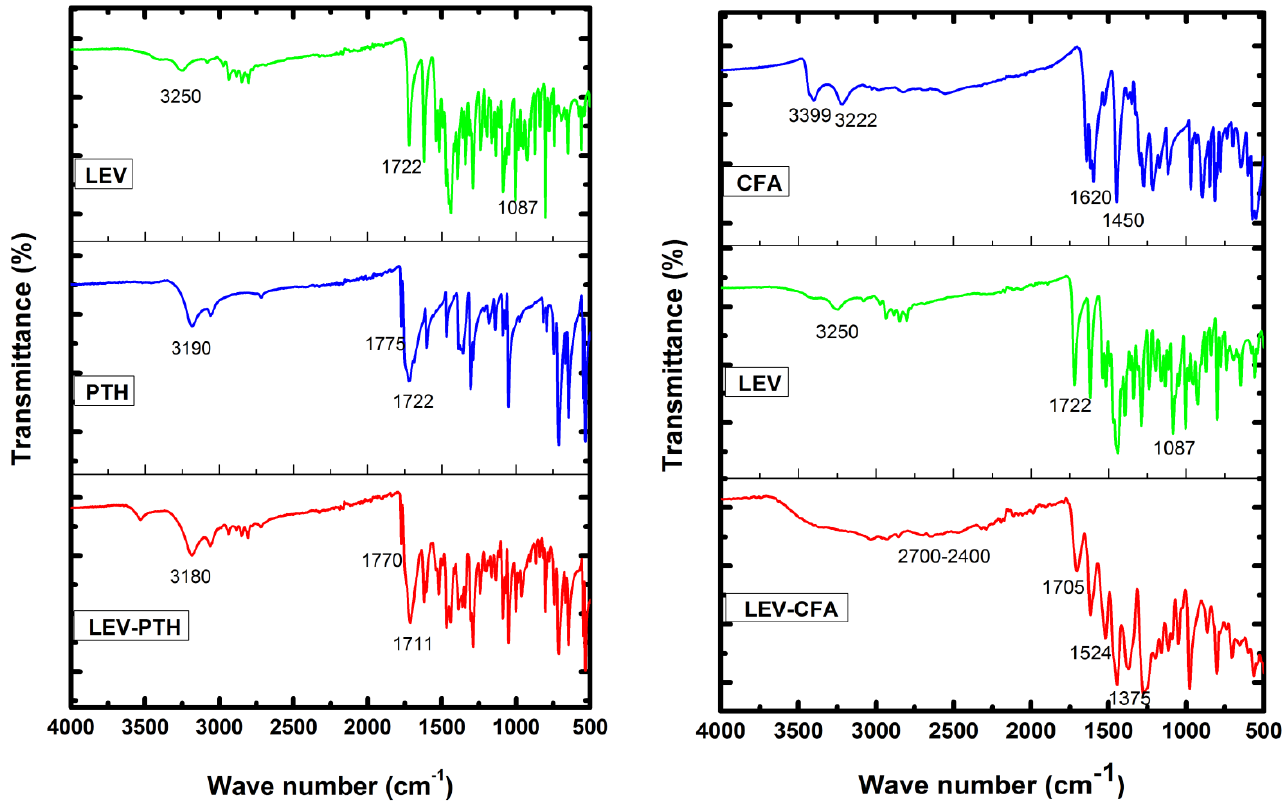
Figure 2. FTIR spectra of cocrystals (LEV-PTH) and amorphous salt (LEV-CFA) and respective pure components wave number (4000 – 500 cm −1 ).